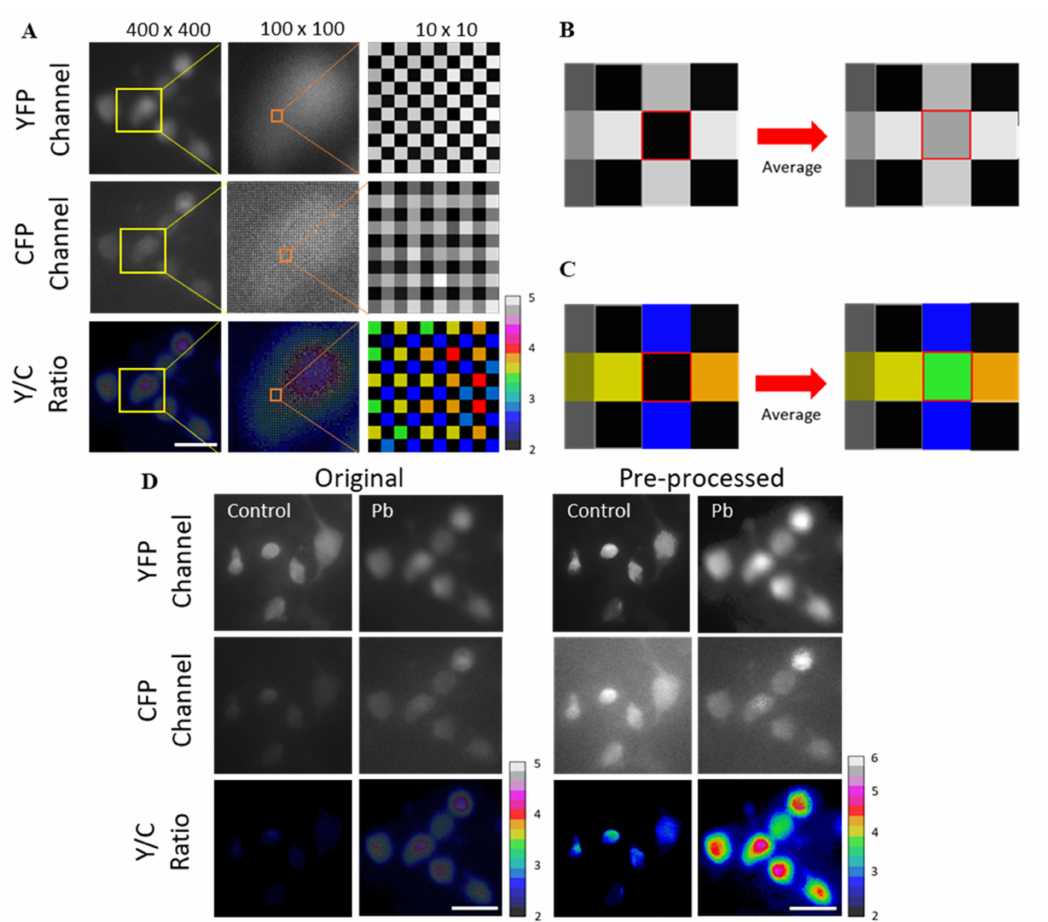
Figure 3. Pre-processing of pMet-lead fluorescence images taken with a smartphone camera. ( A ) Met-lead-expressing cells taken from pMet-lead were first separated into YFP and CFP channels. The Y/C ratio image was obtained through the division of fluorescence from the YFP and CFP channels. Selected regions of YFP, CFP, and Y/C ratio from an image size of 400 × 400 pixels (left) were further magnified to 100 × 100 pixels (middle) and 10 × 10 pixels (right). Black spots can be observed from both the YFP and CFP channels. ( B , C ) A conceptual illustration of the function of the image processing step described in Section 2.5 to fill black spots with signals, from adjacent regions of fluorescent YFP or CFP signals ( B ), or Y/C ratios ( C ). ( D ) Comparison of images without (control) or with Pb (100 nM) taken from pMet-lead without (original) and with (pre-processed) corrections as described in Section 2.5. Scale bars, 30 µ m. The ratio color bars are from 2 to 5 for the original images (left), and from 2 to 6 for the pre-processed images